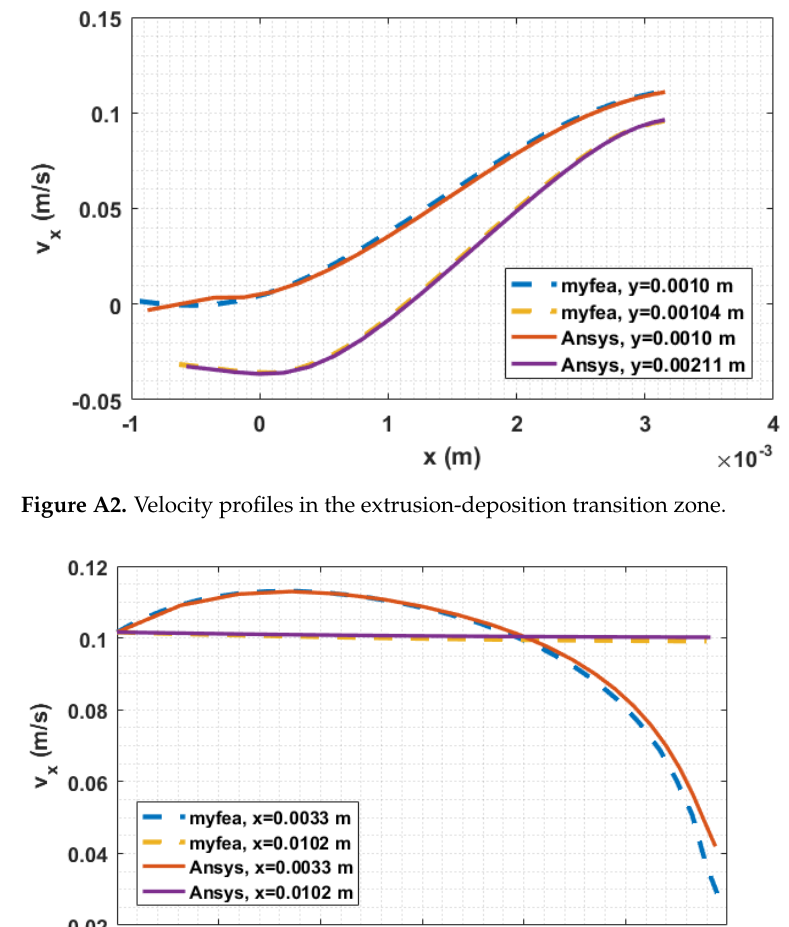
Figure A4. Outlines of the predicted extrudate swell of the deposited bead. References 1.